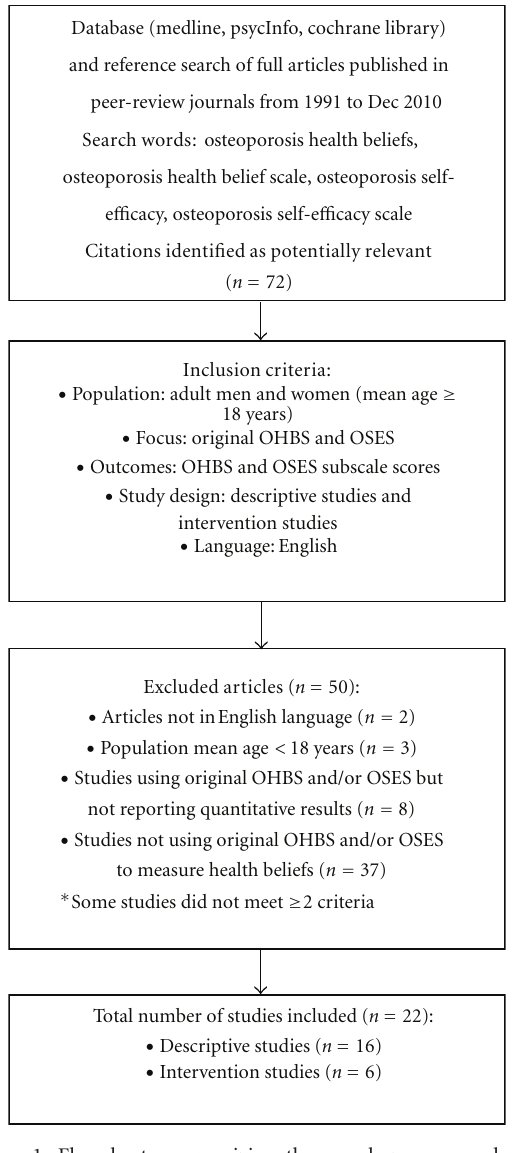
Figure 1: Flowchart summarizing the search process and study